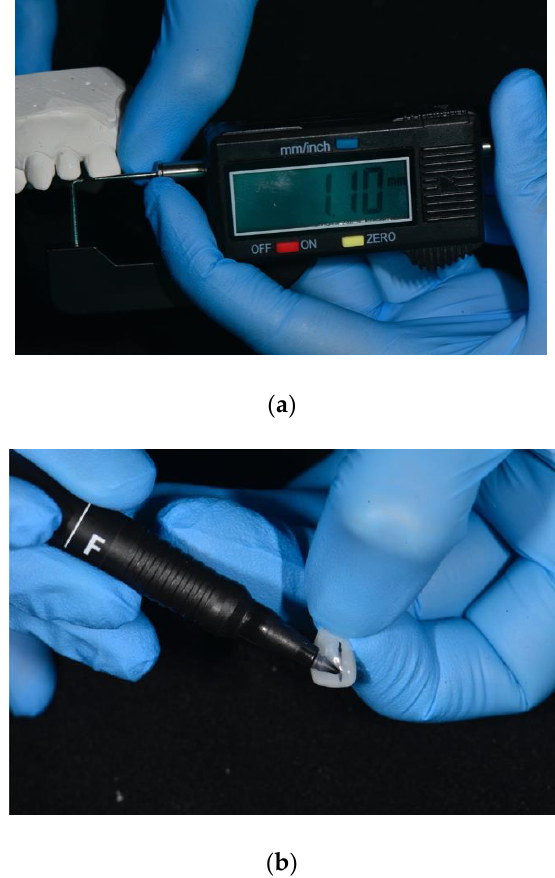
Figure 5. ( a ) The size of the diastema is measured with a digital caliper; ( b ) the size of the diastema is transferred to the veneer with a thin marker.